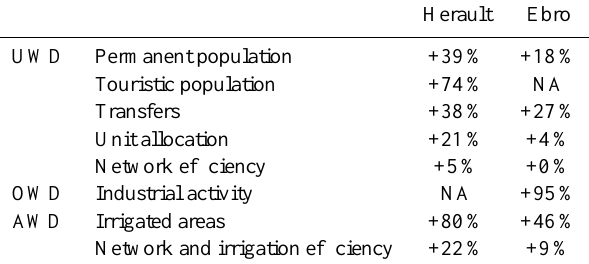
Table 1. Trend water use scenarios at the 2050 horizon in the Her- ault and the Ebro basins: variation of the main variables between the 2000s and the 2050s. UWD: urban water demand, AWD: agri- cultural water demand, OWD: other water